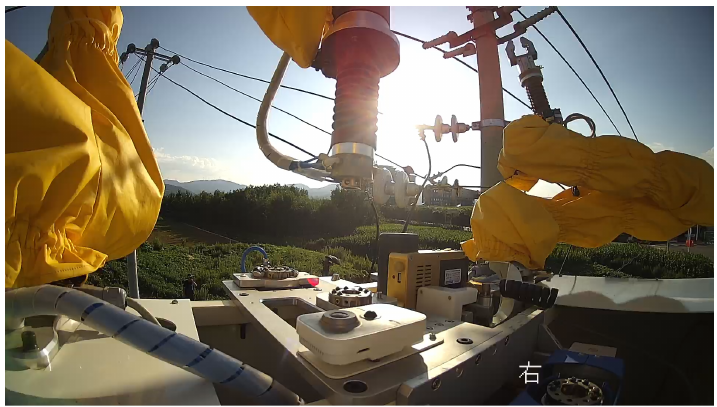
Figure 4. Dense tool placement and small space limit robot